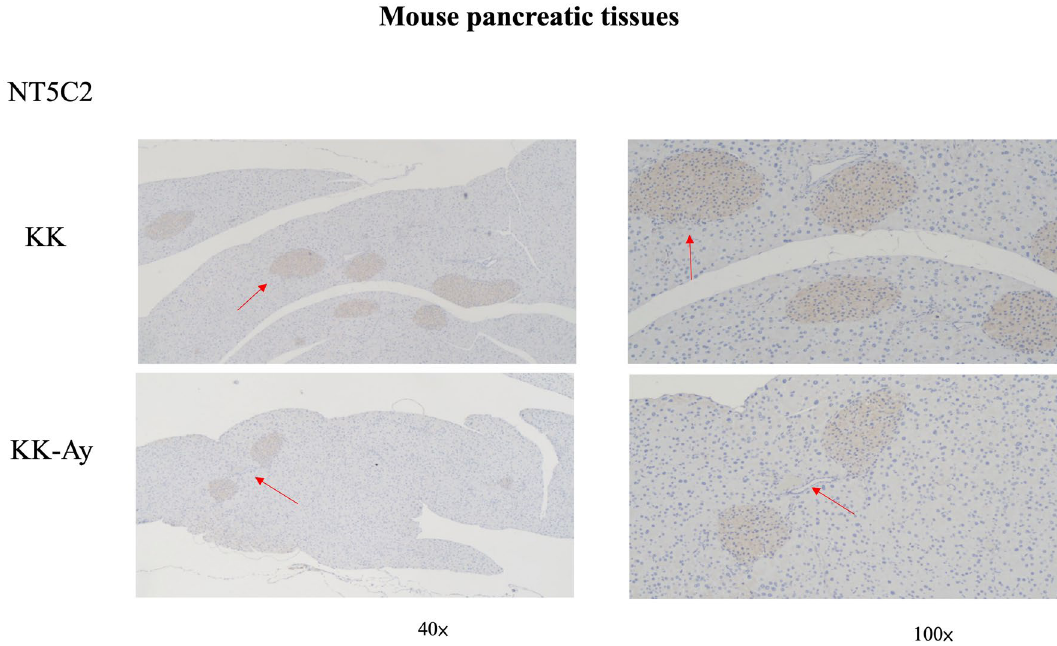
Figure 2. The original incorrect version of Figure